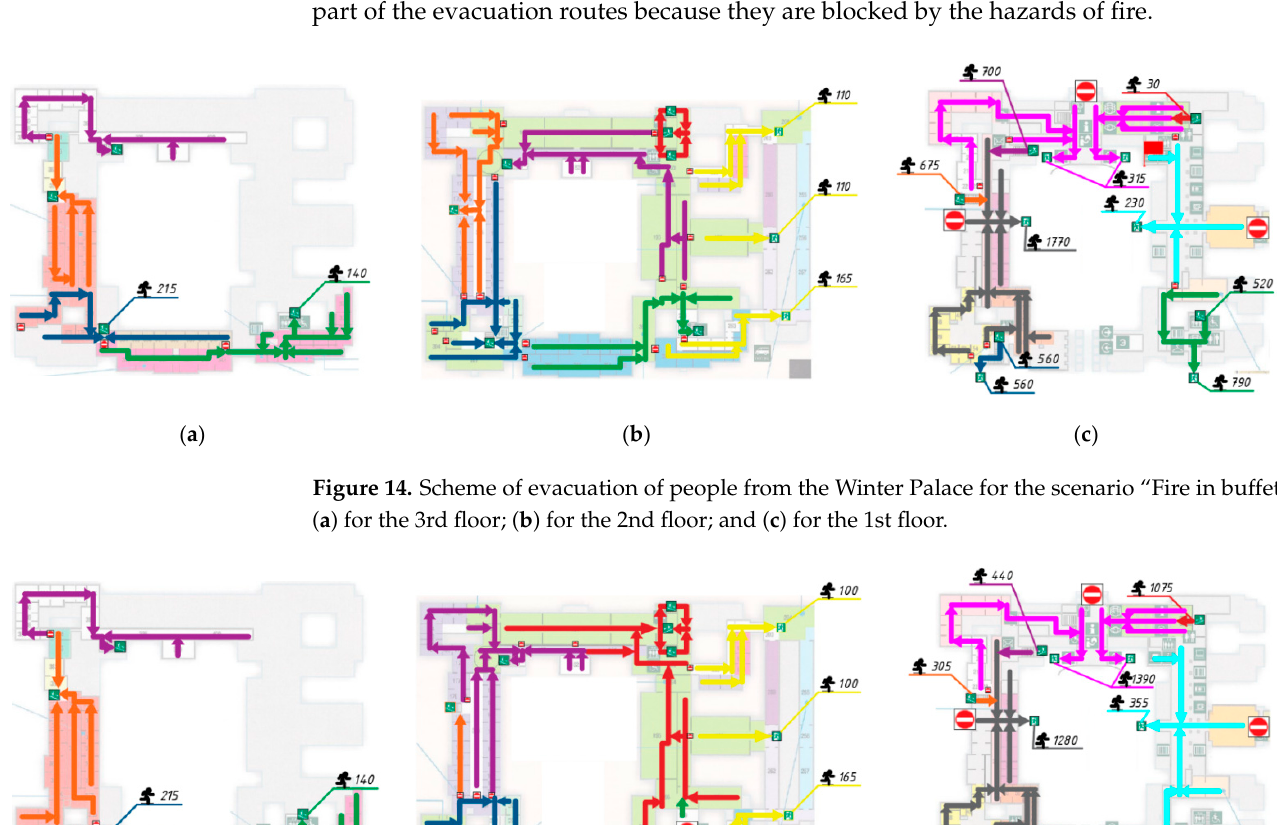
( c ) Figure 16. Scheme of evacuation of people from the Winter Palace for the scenario “Fire in the foyer of the Wooden Staircase”: ( a ) for the 3rd floor; ( b ) for the 2nd floor; and ( c ) for the 1st floor. ( a ) ( c ) Figure 17. Scheme of evacuation of people from the Winter Palace for the scenario “Fire in the Saltykov’s Entrance”: ( a ) for the 3rd floor; ( b ) for the 2nd floor; and ( c ) for the 1st floor.